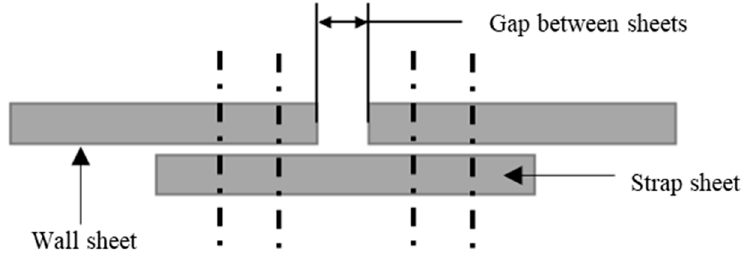
Figure 2. Schematic diagram of single-strap butt joint.